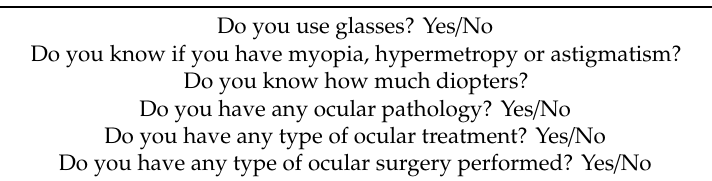
Table 1. Telephone screening questions.